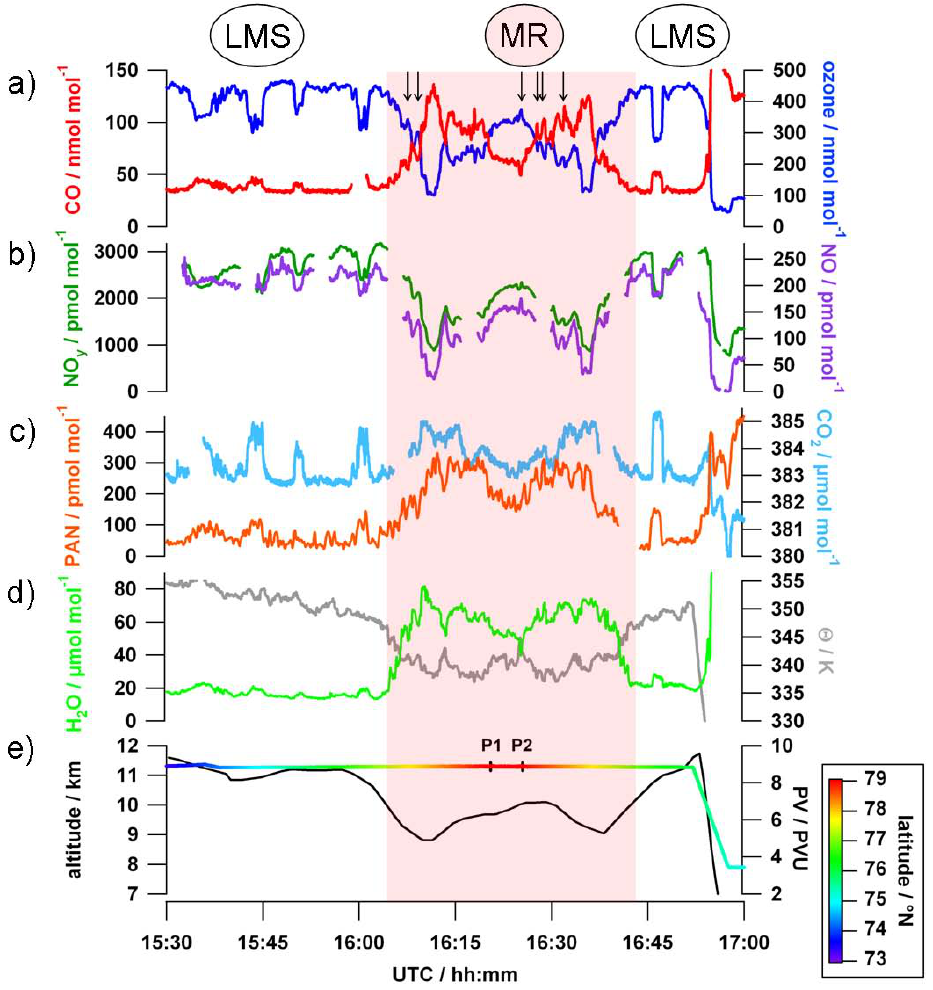
Fig. 2. Time series of measured trace gases for the GRACE flight on 10 July 2008, between 15:30 and 17:00UTC. (a) O 3 in blue and CO in red, (b) NO y in green and NO in purple, (c) PAN in orange and CO 2 in light blue, (d) H 2 O in light green and potential temperature 2 in grey. Missing data correspond to internal calibration periods. (e) Flight altitude (latitude is colour-coded) and potential vorticity in black, as interpolated from the ECMWF analysis at 18:00UTC. The flight segment discussed in the present study is highlighted in light red (“MR”), whereas the remaining data at this flight altitude are denoted by “LMS” (lowermost stratosphere). See text for more